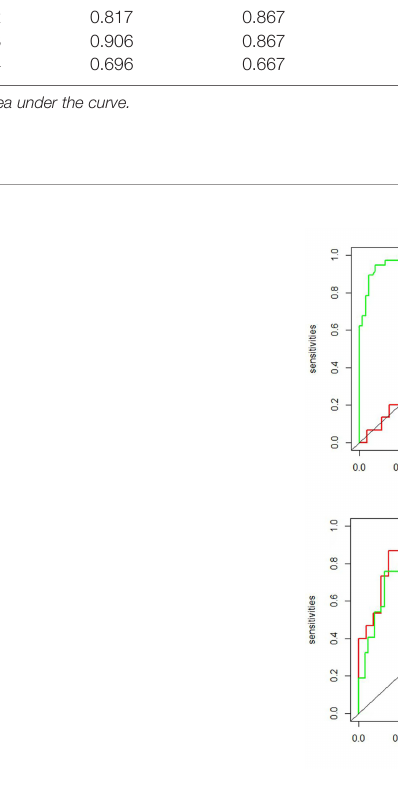
FIGURE 4 | Receiver operating character (ROC). ROC of the 4 radiomics models in the training and testing cohorts.